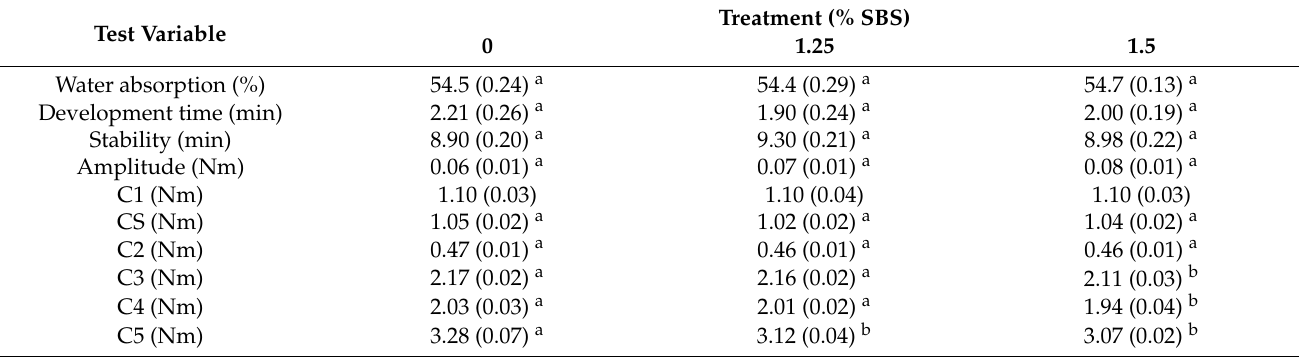
Table 6. Mean (sd) mixolab characteristics of wheat flours.